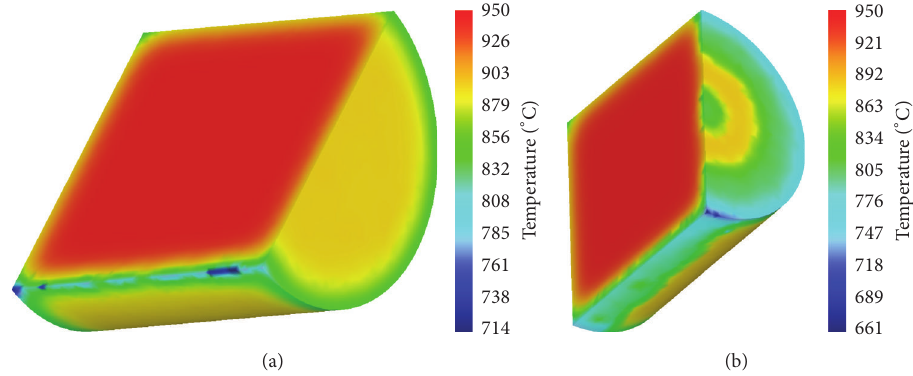
Figure 5: Distribution of temperature field of billet: (a) the first stage (b) the second stage.